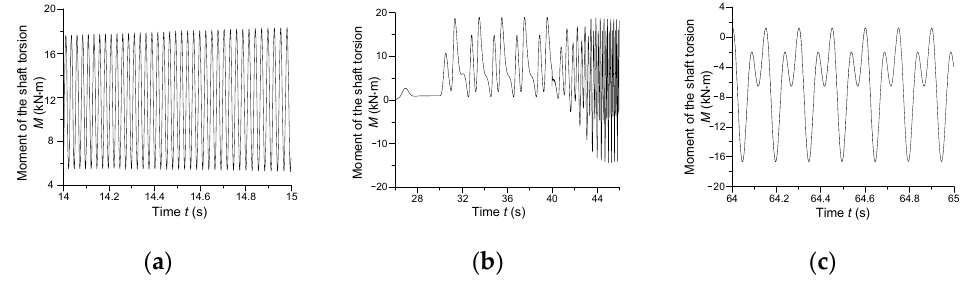
Figure 12. Instantaneous waveforms of the synchronous drive’s moment of torsion for the following time intervals: ( a ) t ∈ (14; 15) s; ( b ) t ∈ (26; 46) s; and ( c ) t ∈ (64; 65) s.